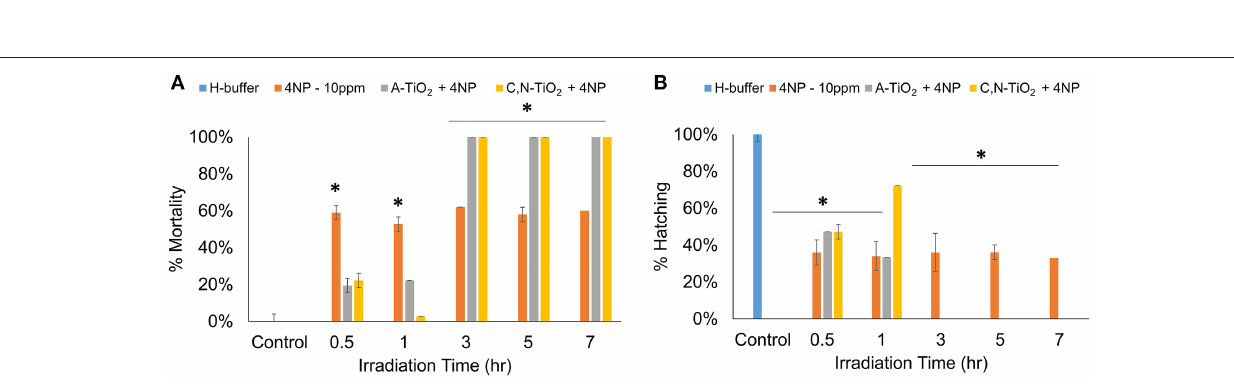
FIGURE 7 | Degradation time-dependent toxicity of zebrafish treated after 72hpf. (A) Mortality rate, (B) Hatching rate. (Values are expressed as means ± S.D, * P < 0.01).